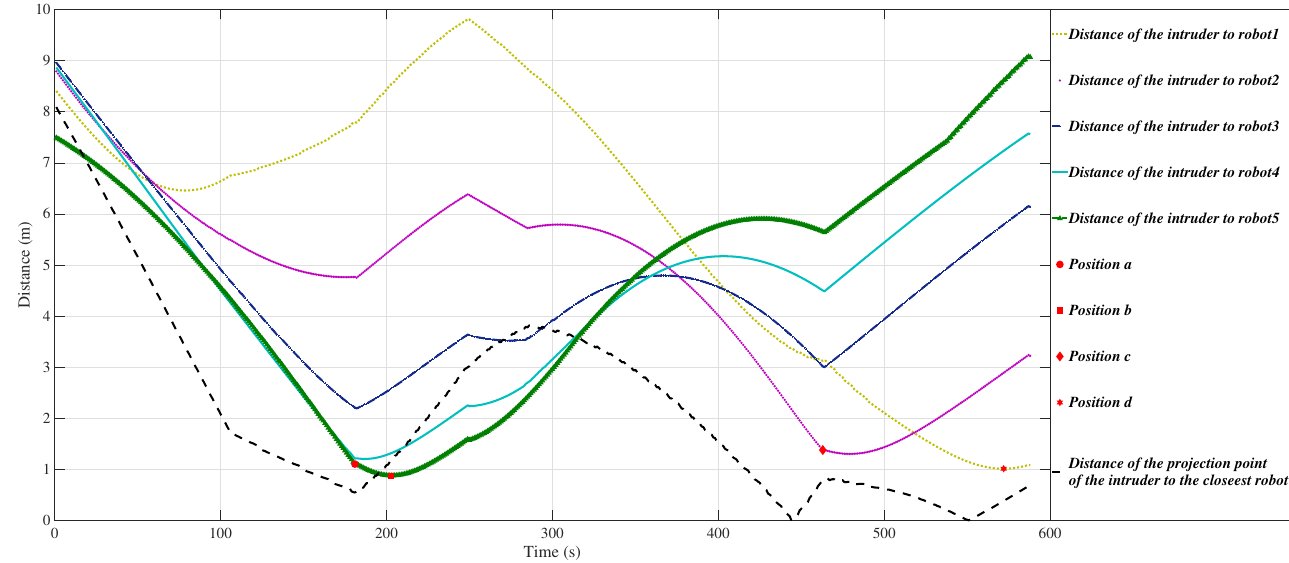
Figure 5. The evolution of the y -coordinates of the intruder and the USVs in segment S